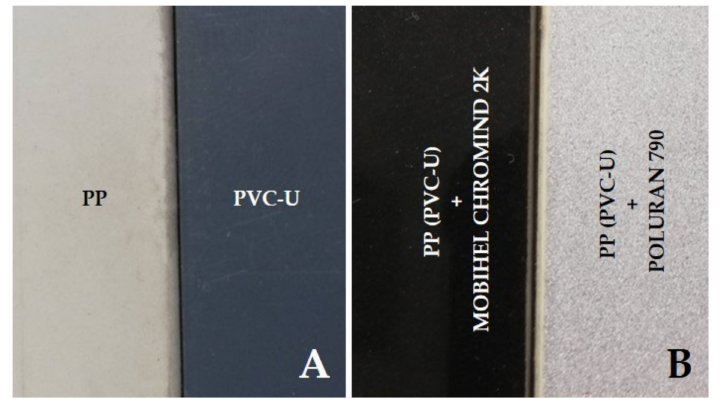
Figure 1. Test samples: ( A ) polymers before coating; ( B ) polymers after